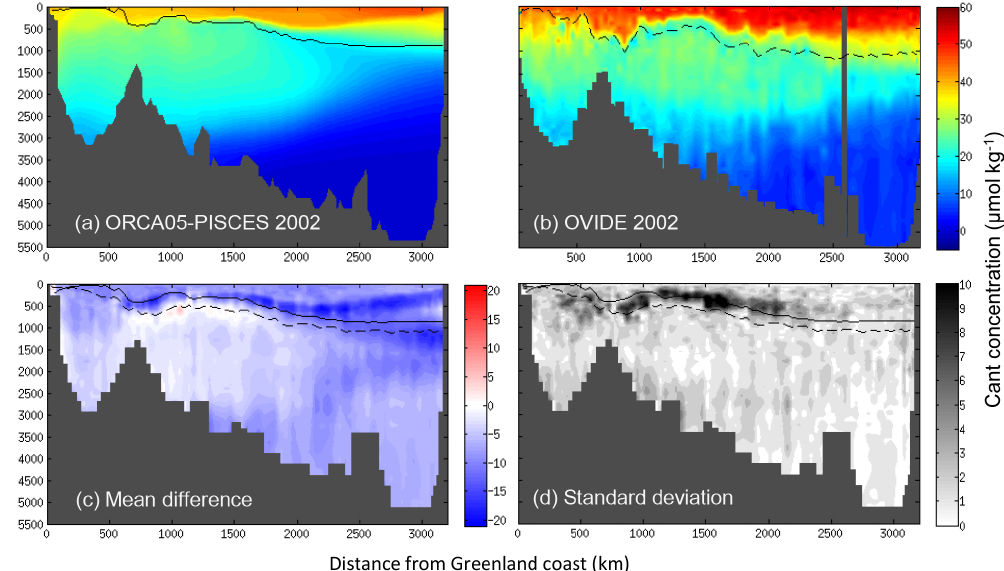
Figure 6. Water column distribution of anthropogenic C concentrations (µmolkg − 1 ) along the Greenland–Portugal OVIDE section in June 2002: (a) model output and (b) as estimated from the OVIDE data set. The mean and standard deviation of differences between these two assessments (model–observation) over the OVIDE period (June 2002-04-06-08-10) are displayed in panels (c) and (d) . Black continuous and dashed lines indicate the limit between the upper and the lower MOC in the model and in the OVIDE data set, respectively.